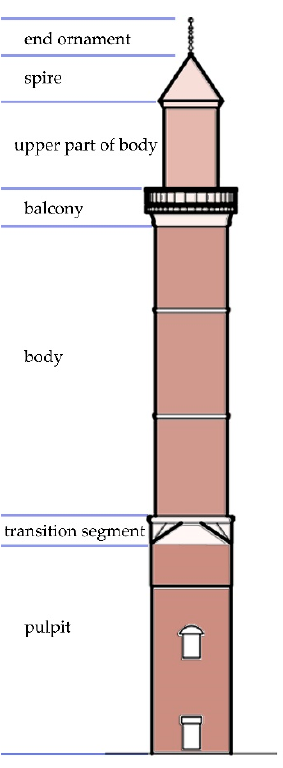
Figure 3. Parts of the minaret of the Ulu